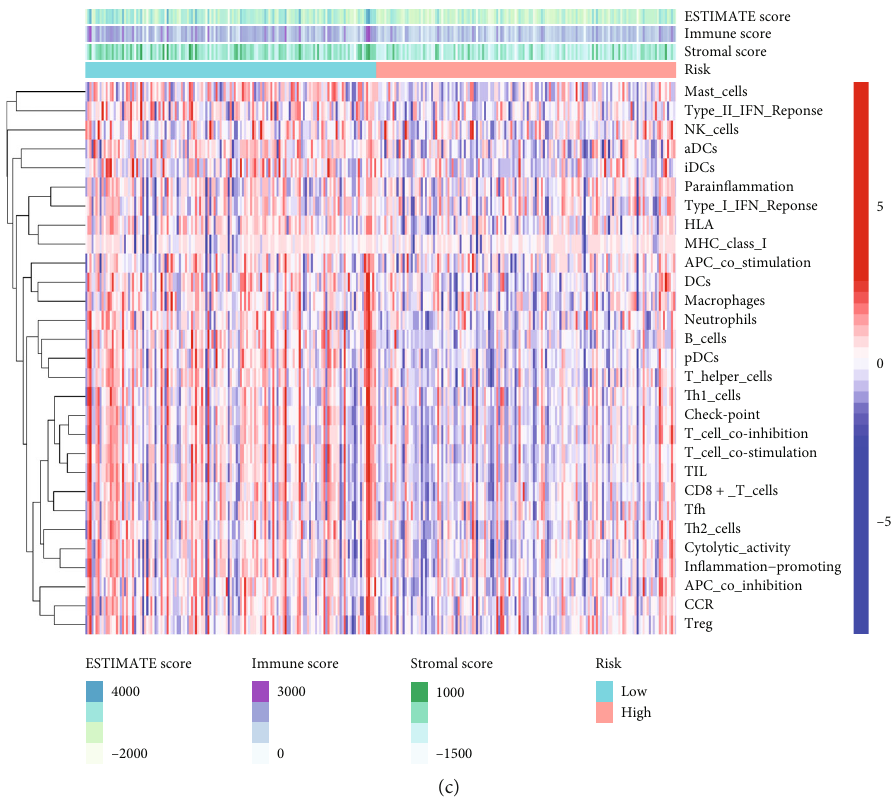
Figure 9: Immune in fi ltration correlation analysis. (a, b) Analyze the immune di ff erences between high- and low-risk samples from 16 immune cells and 13 immune-related functions. (c) Heat map of stromal score, immune score, and estimate score in high- and low-risk groups. ∗ P < 0 : 05 ; ∗∗ P < 0 : 01 ; ∗∗∗ P < 0 : 001